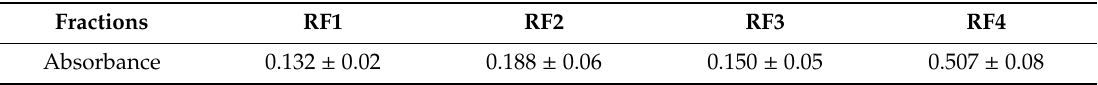
Table 2. Absorbance of RF1-RF4 at 420 nm 1 .